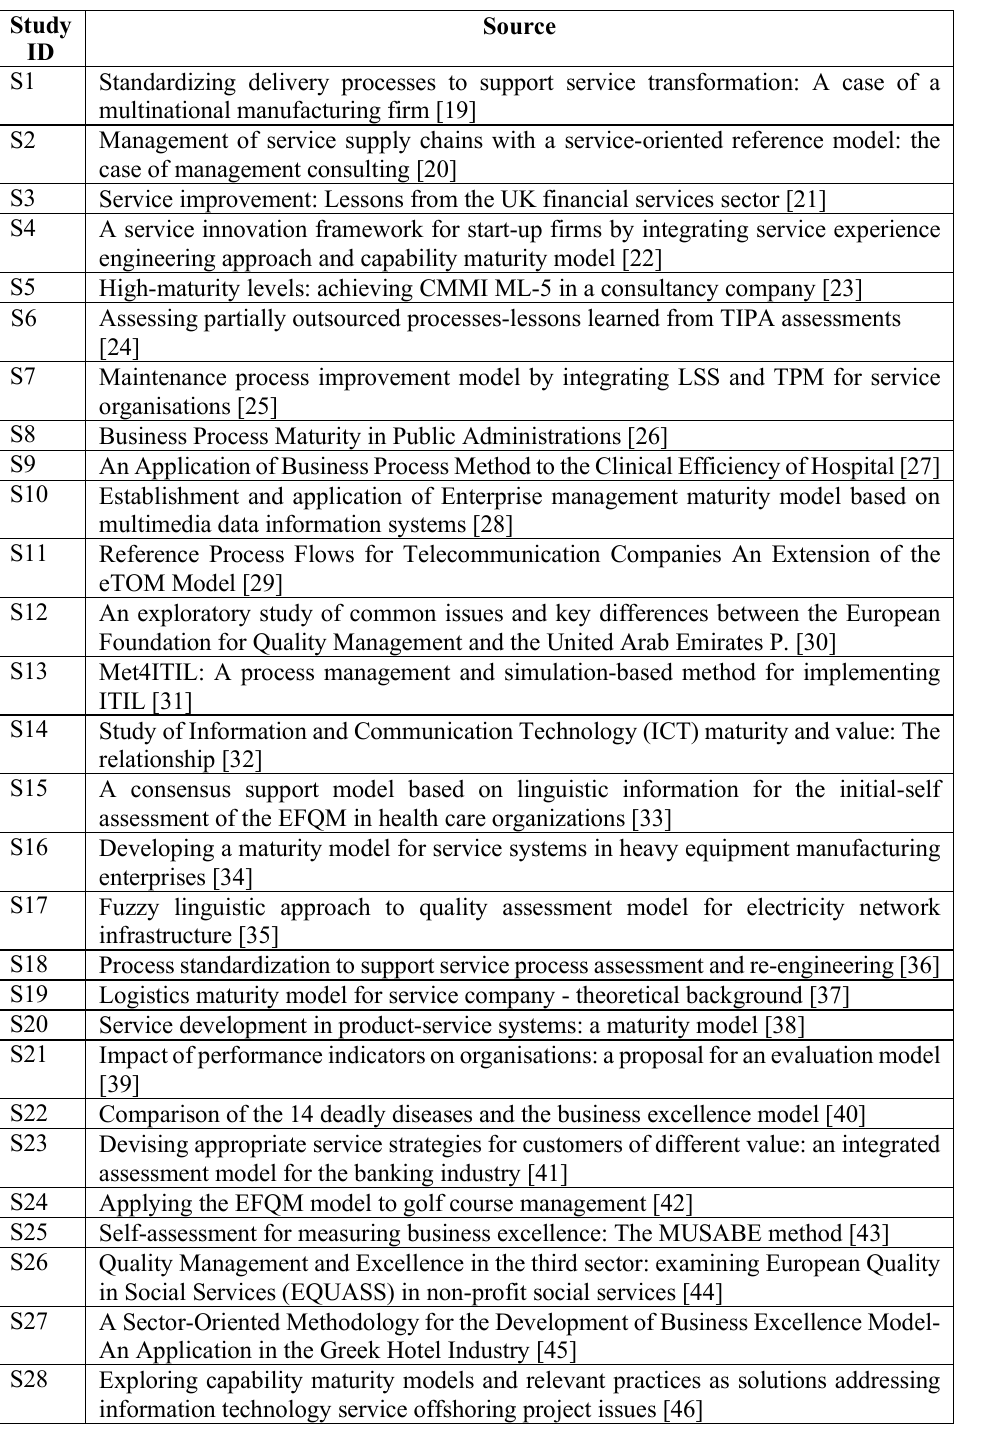
Table 2 : Primary